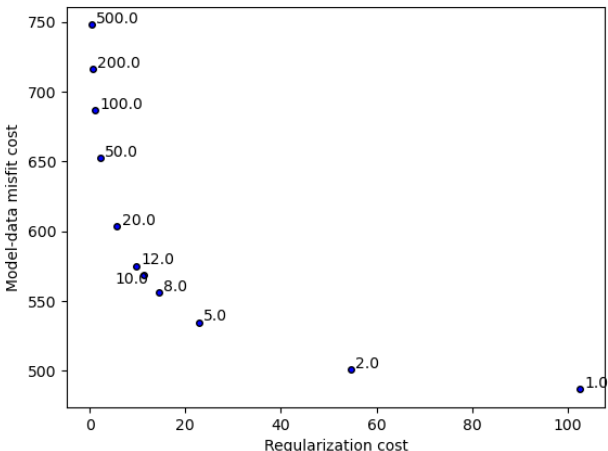
Figure 1. An L curve showing the trade-off between model misfit (first and second terms of Eq. 32) and the regularization cost (the second terms of Eq. 32 divided by γ ). Associated values of the reg- ularization parameter γ are shown. In all optimizations, δ is equal to 10 − 5 , and observational points occur at intervals of